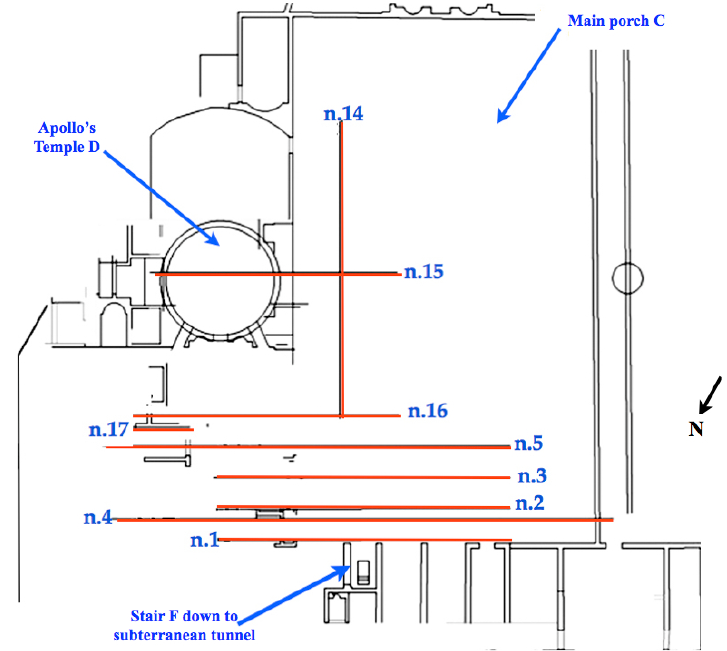
Fig. 10. Plan of our geo-resistivimeter measurements (A. M. Marras).